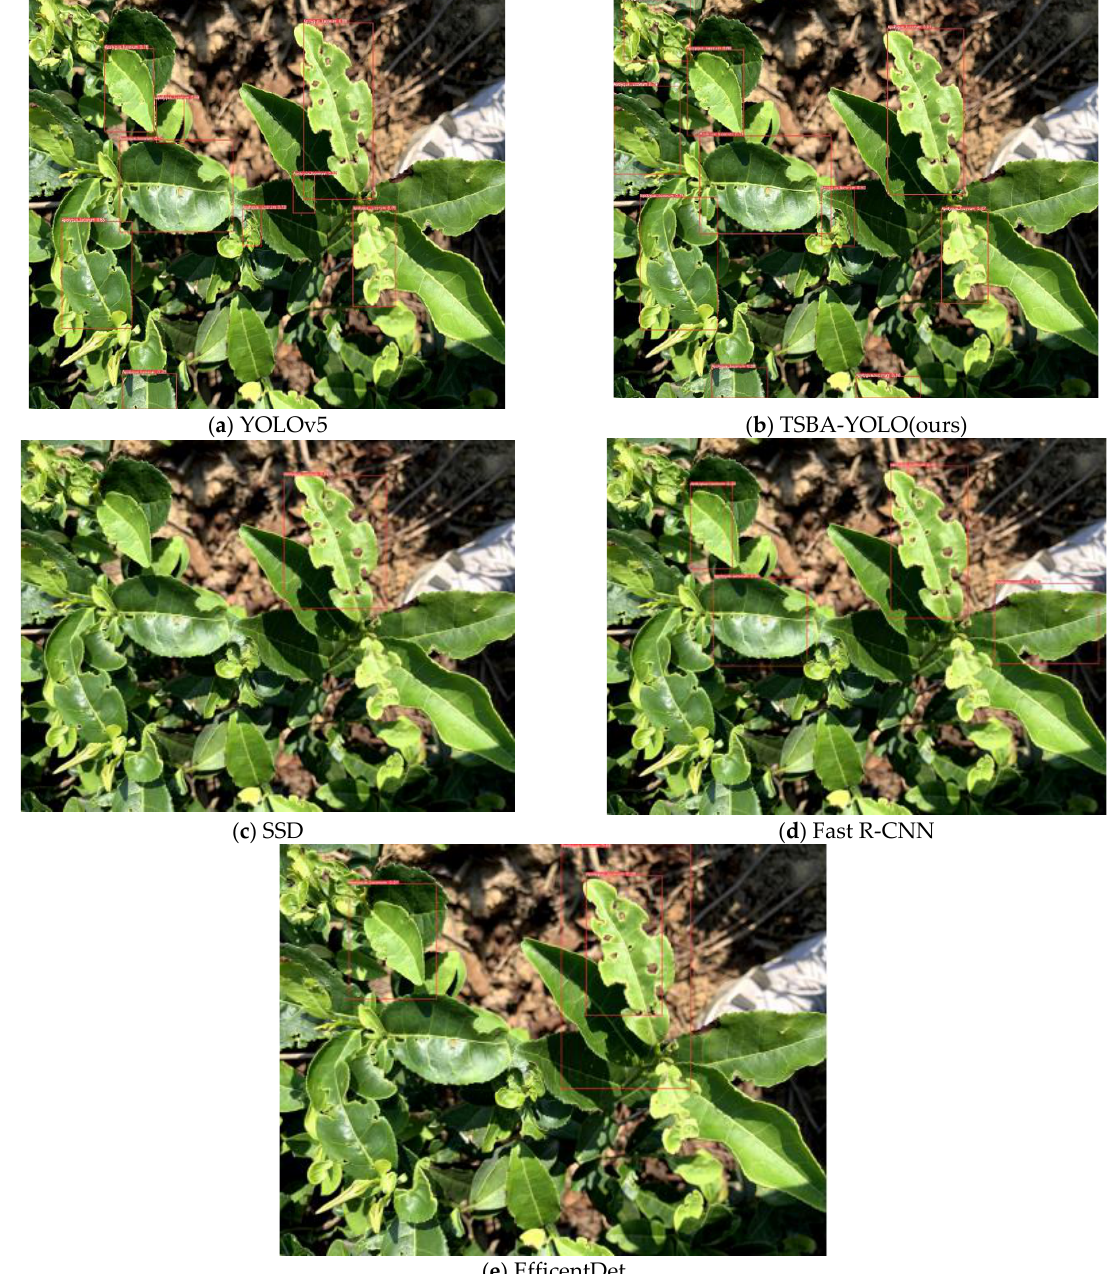
Figure 17. Comparison of tea disease detection results using different models. ( a – e ) are the detec- tion results of the different models. results of the different